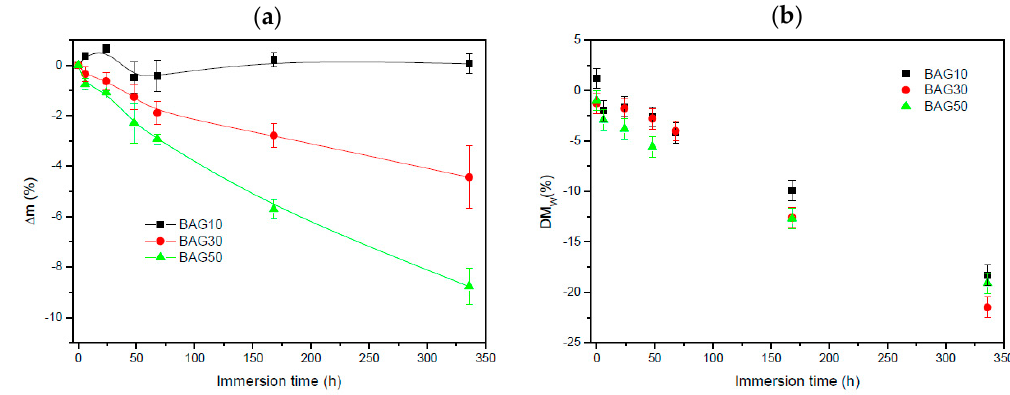
Figure 5. Change in sample mass ( a ) and the polymer molecular weight ( b ) as a function of immersion time.